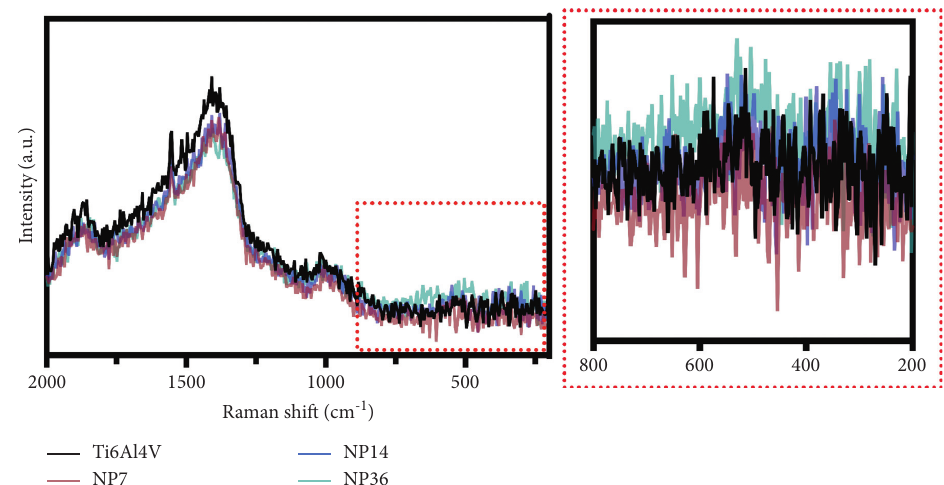
Figure 2: Raman characterization of the experimental materials.